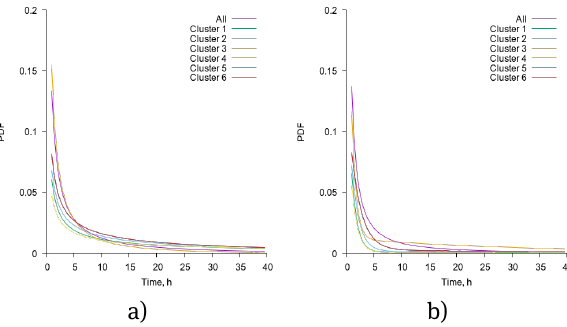
Figure 2: Availability (a) and unavailability (b) per-cluster probabil- ity density